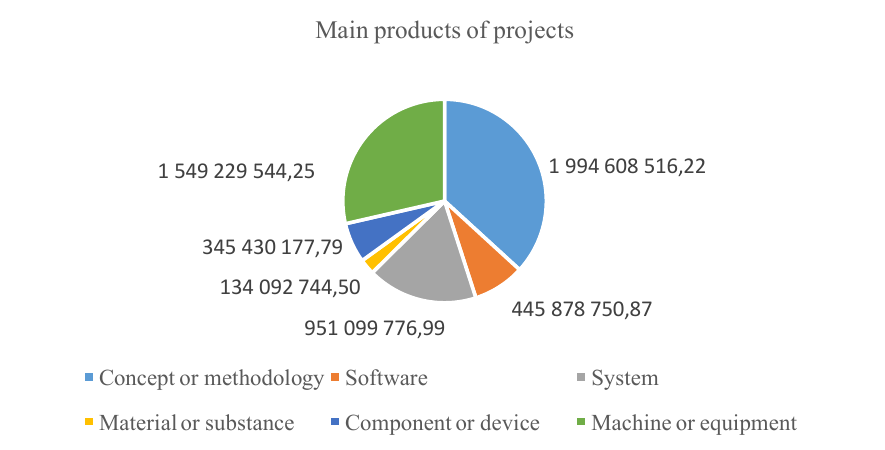
Fig. 4 . Main products of projects (ANEEL, march